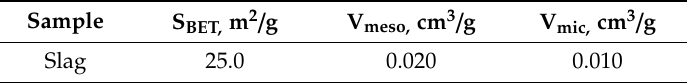
Table 6. Properties of the slag